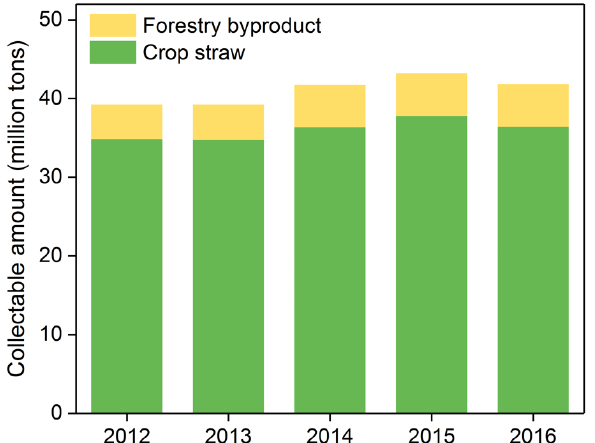
Figure 3. The total collectable amount of biomass resource in Anhui Province (AHP) from 2012 to 2016. Abbreviation of cities: SZ for Suzhou city, BZ for Bozhou city, FY for Fuyang city, BB for Bengbu